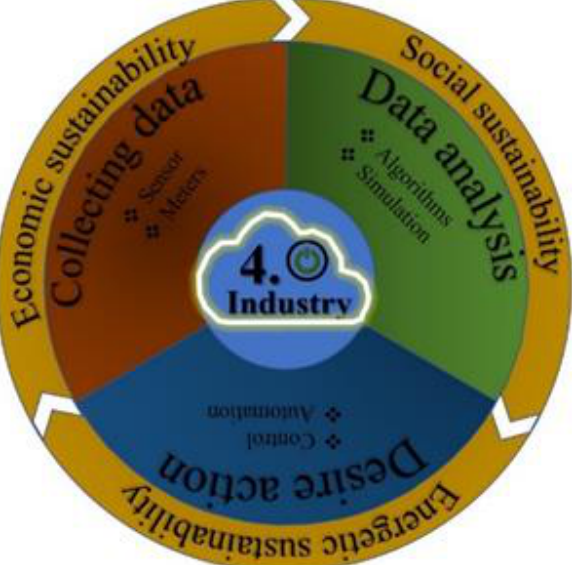
Figure 1. Sustainability aspects of Industry 4.0.